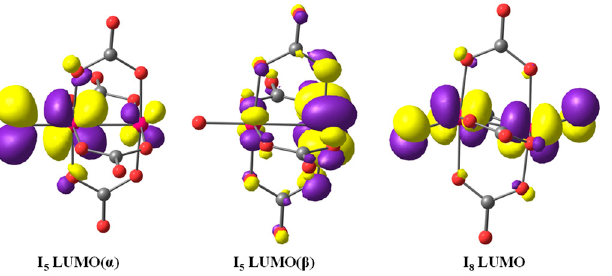
Figure 15. LUMO representations for the species [Ru IV Ru II ( µ -CO 3 ) 4 (O)] 4 − (I 5 ) and [Ru IV Ru IV ( µ - CO 3 ) 4 (O) 2 ] 4 − (I 8 ).